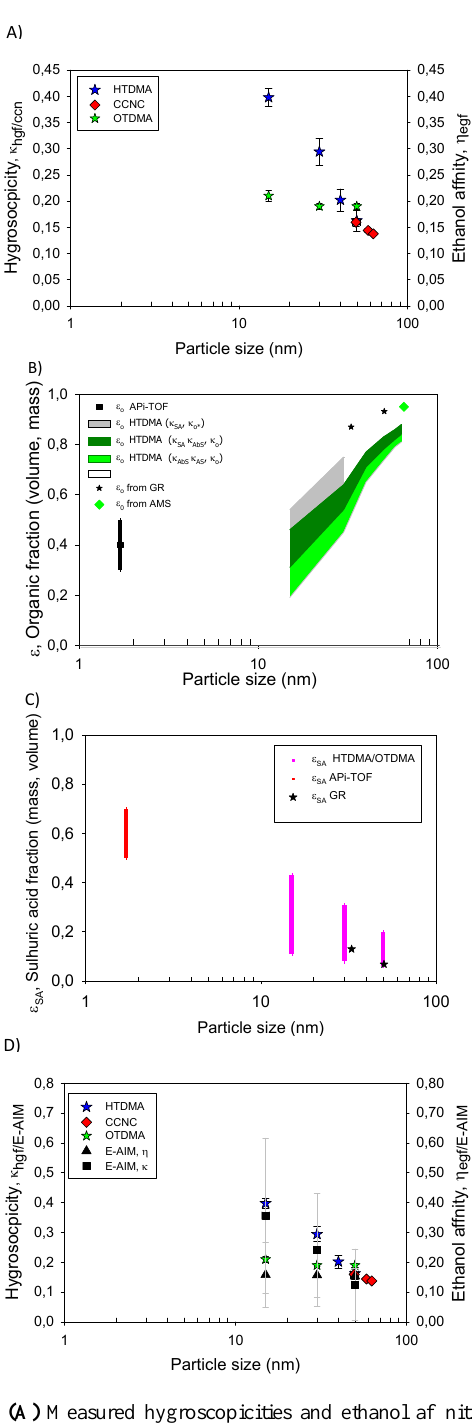
Fig. 5. (A) Measured hygroscopicities and ethanol affinities; (B) approximated organic fraction from the H-TDMA/CCNC, AMS (for aerodynamic diameter) ( ε o , vol%), and GF measurements ( ε o , nmh − 1 ); (C) SA vol% in the particles versus particle size in pres- ence of PD; and (D) hygroscopicities and ethanol affinities; experi- mental results and values predicted from the composition using the E-AIM